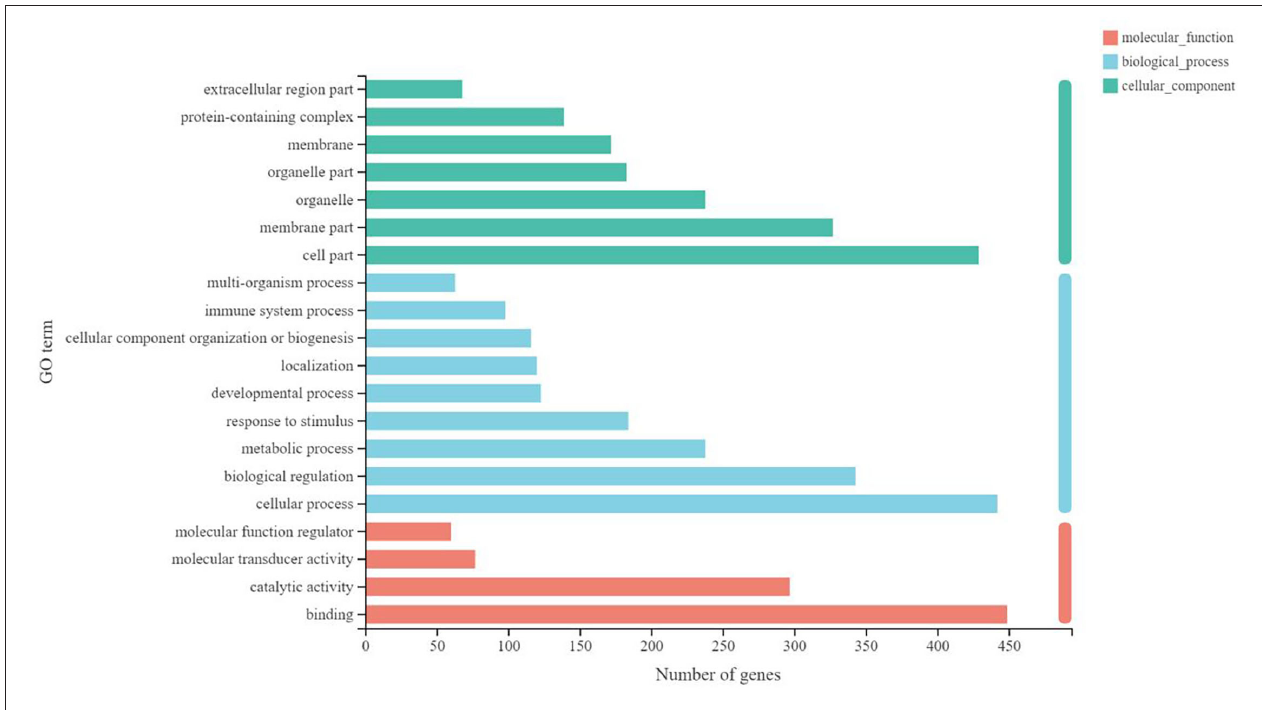
FIGURE 4 | Gene function annotation in GO.